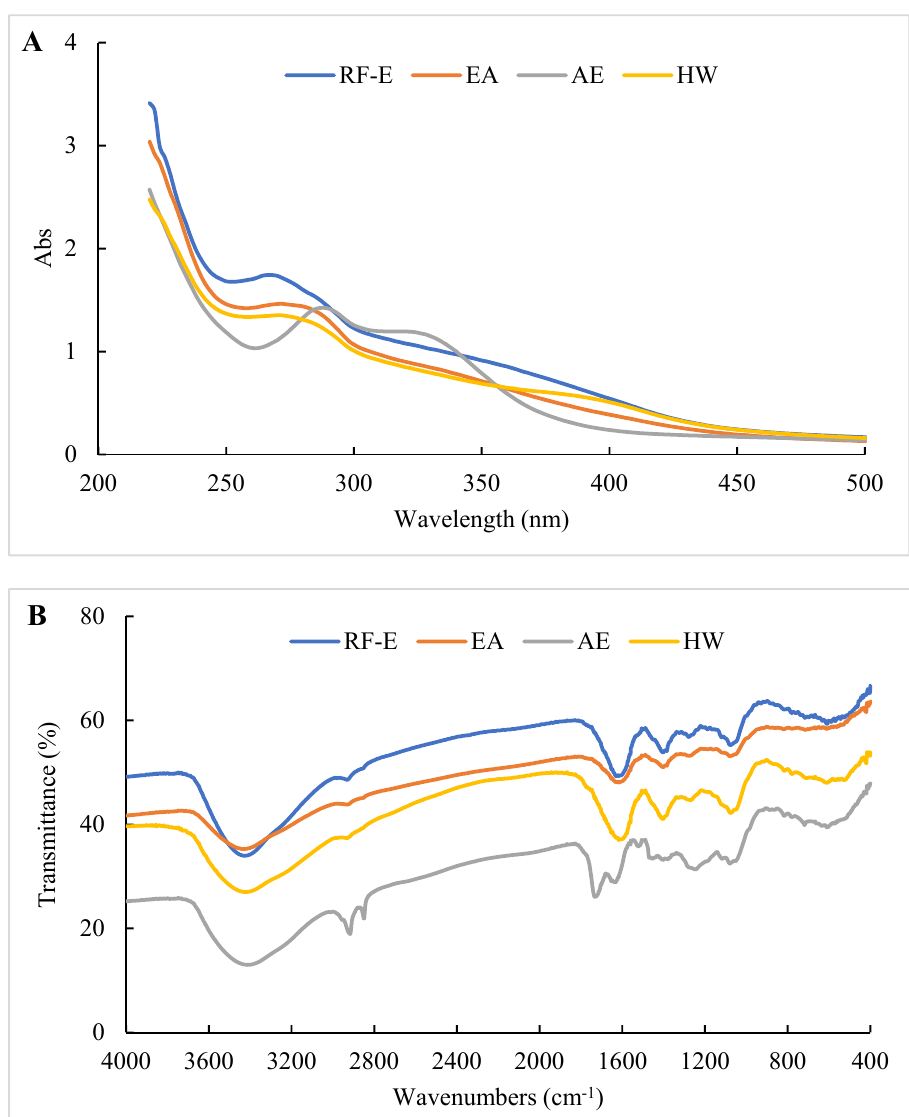
Figure 3. UV ( A ) and FTIR ( B ) spectrophotometric analysis of A. trifoliata flower extracts. See Figure 1 for abbreviations.